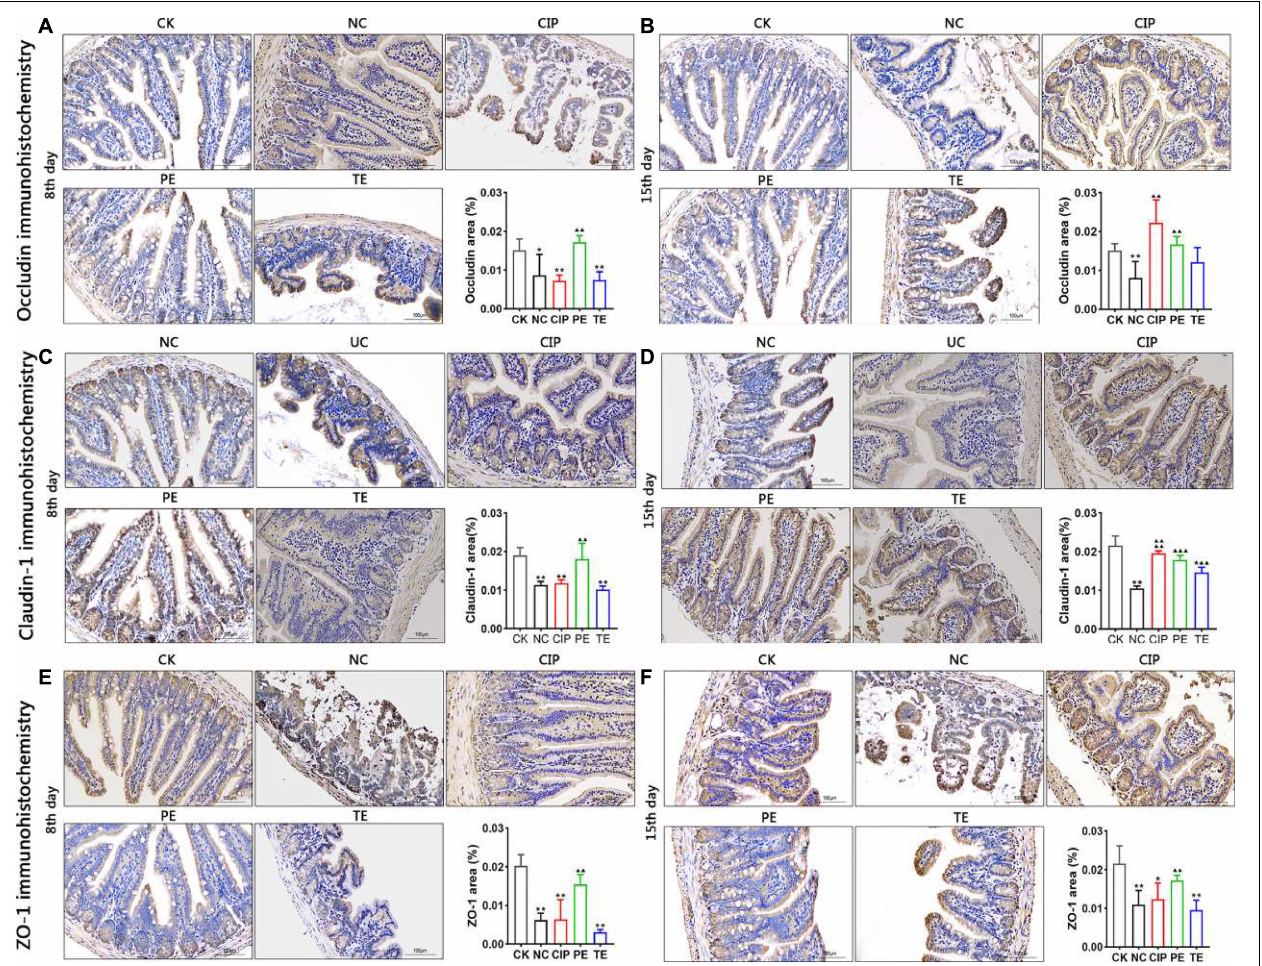
FIGURE 5 | TJ proteins expression with E. coli and L. paracasei . (A,C,E) Representative the occludin, claudin-1 and ZO-1 protein repressive at day 8. CK group administrate with 0.9% saline; PE group administrate with L. paracasei ; NC, CIP and TE groups administrate with E. coli . (B,D,F) Representative the occludin, claudin-1 and ZO-1 protein repressive at day 15. CK and NC group administrate with 0.9% saline; CIP group administrate with ciprofloxacin; PE group administrate with E. coli , and TE group administrate with L. paracasei . *Representative compared with CK group. * P < 0.05; ** P < 0.01. (cid:78) Representative compared with NC group. (cid:78)(cid:78) P < 0.01, (cid:78)(cid:78)(cid:78) P < 0.001, (cid:78)(cid:78)(cid:78)(cid:78) P < 0.0001 as determined by Student’s t